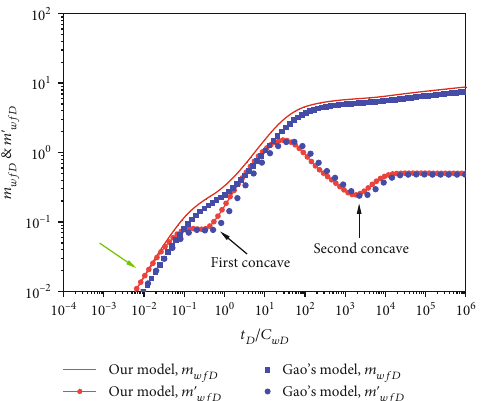
Figure 8: The typical curve comparison of Gao ’ s model and our model.